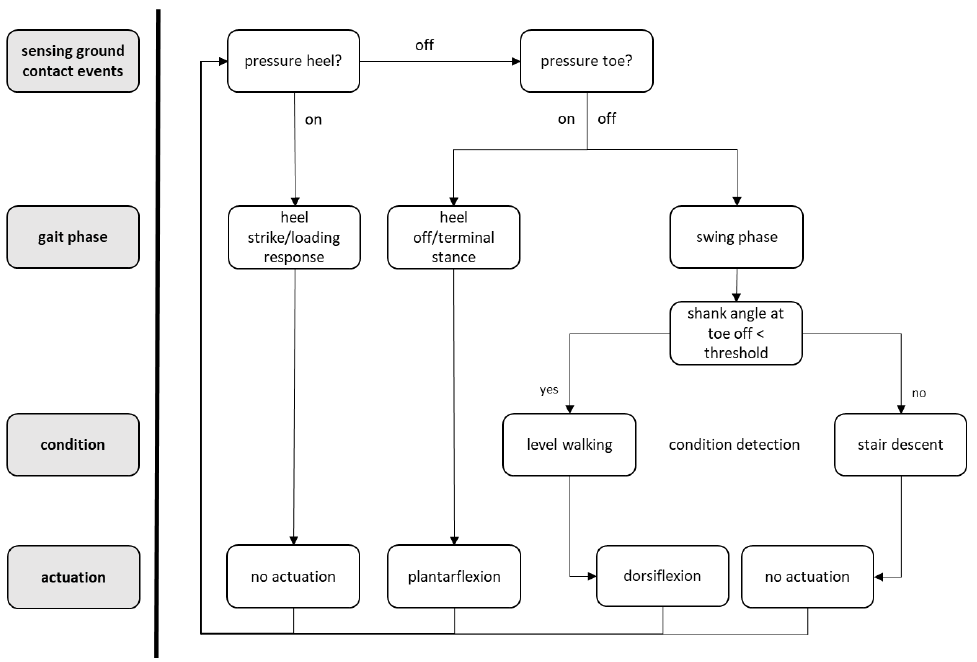
Figure 4. Control scheme.